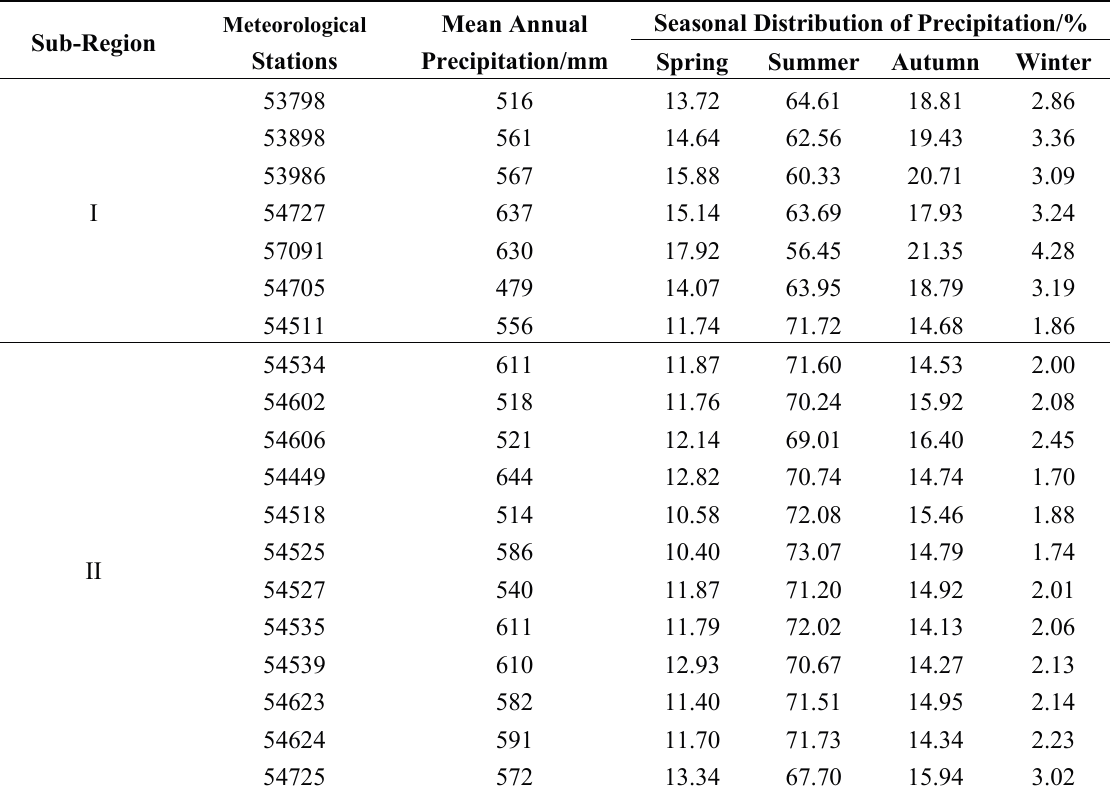
Table 3. Seasonal distribution of mean annual precipitation at meteorological stations in NCP.